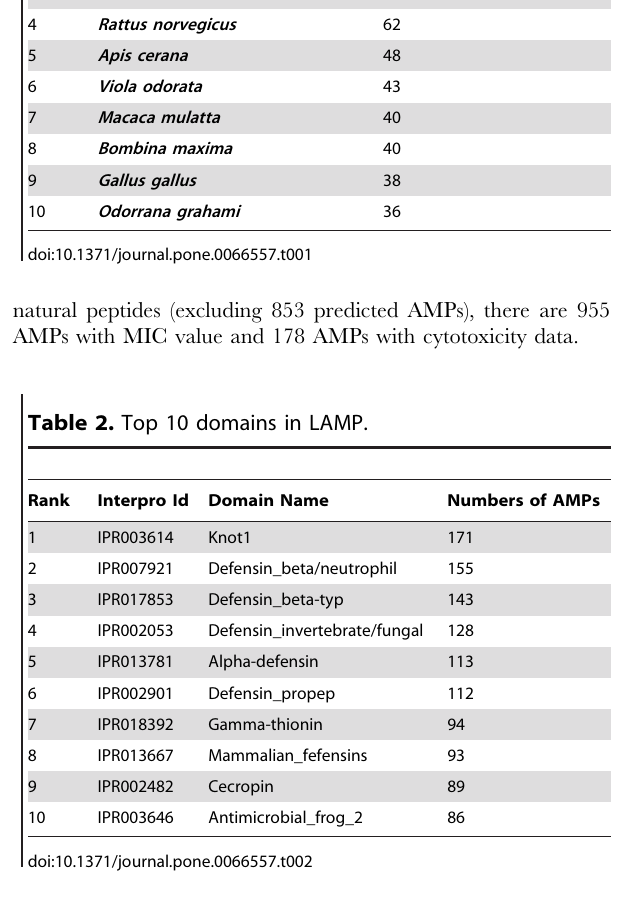
Figure 2. Screen shots of the LAMP search interface. The screen shots show the advanced search and result views. Please note that not all fields are shown.